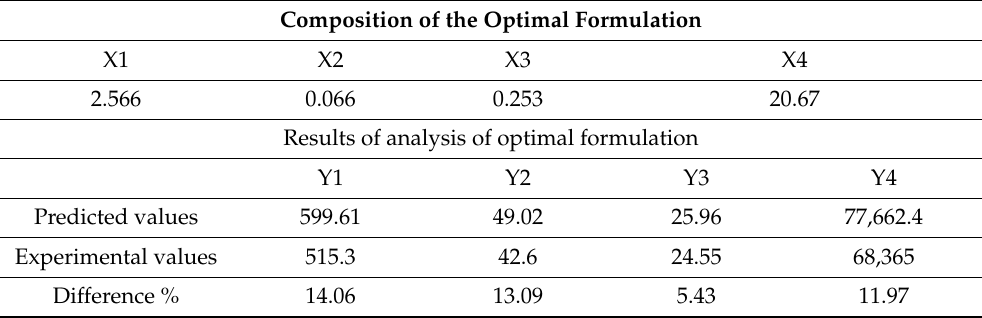
Table 6. The composition of the optimal formulation and the results of the analysis of optimal formulation. Composition of the Optimal